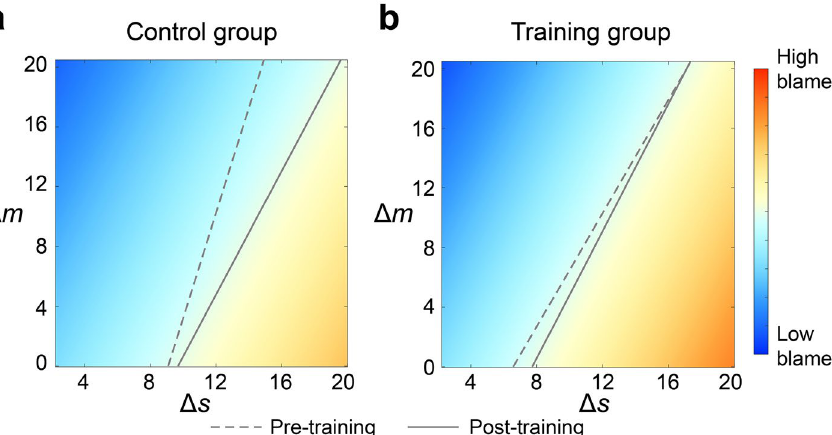
Figure 5. Effects of mindfulness training on the cognitive components of moral judgments. Compared with the Pre-training session (dotted line), the same amount of monetary gain (Δ m ) justifies more harm (Δ s ) in the Post-training session (solid line) for the Control group ( a ). This is not the case for the Training group ( b ). Color reflects blameworthiness judgment in the Post-training